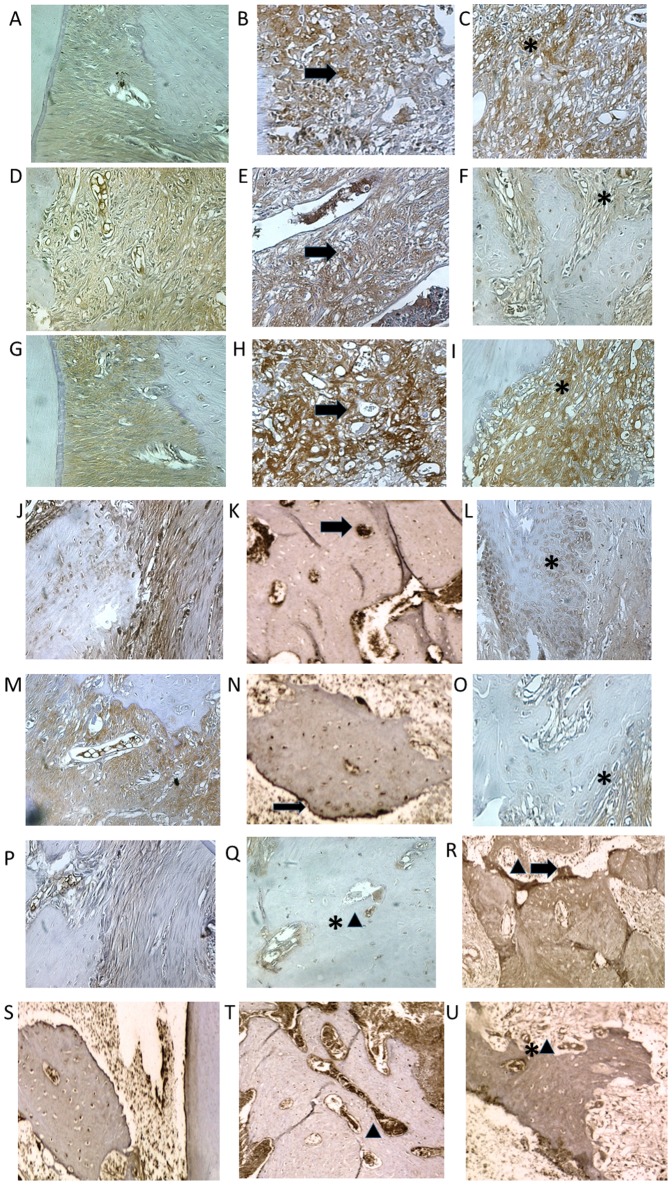
Photomicrographs of periodontal tissue of PD rats treated with AZT, showing immunoreactivity to MMP-2, MMP-9, COX-2, RANK, RANK-L, OPG, and cathapsyn.Rats subjected to saline (A, D, G, J, M, P,S); rats subjected to ligation (B, E, H, K, N, Q,T); rats subjected to ligation and treated with AZT (5 mg/kg) (C, F, I, L, O, R,U). Images are shown at 40× magnification. Bar  = 100 µm. Arrow indicates high or moderate labeling in the periodontal ligament or the alveolar bone. Asterisk indicates mild or moderate labeling in the periodontal ligament or the alveolar bone. Triangle and asterisk indicate mild labeling of OPG in osteoclasts. Triangle and arrow indicate high labeling of osteoclasts. Triangle indicates intense labeling of Cathepsin K on alveolar bone. Asterisk and triangle indicate mild labeling of cathepsin K on alveolar bone.